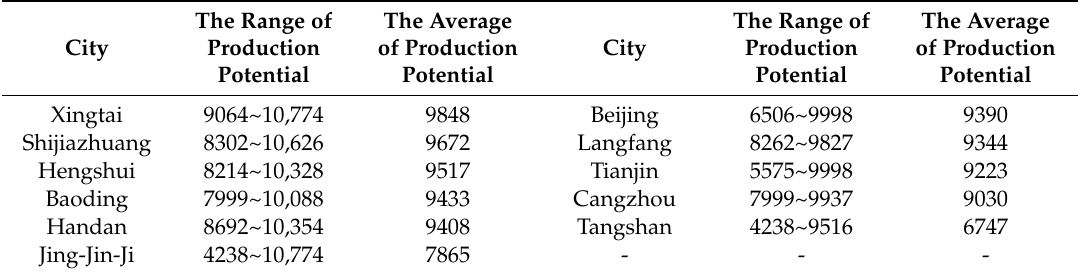
Figure 5. The distribution of the production potential of winter wheat in JJJ. Table 7. Production potential of winter wheat in each city (unit: kg /